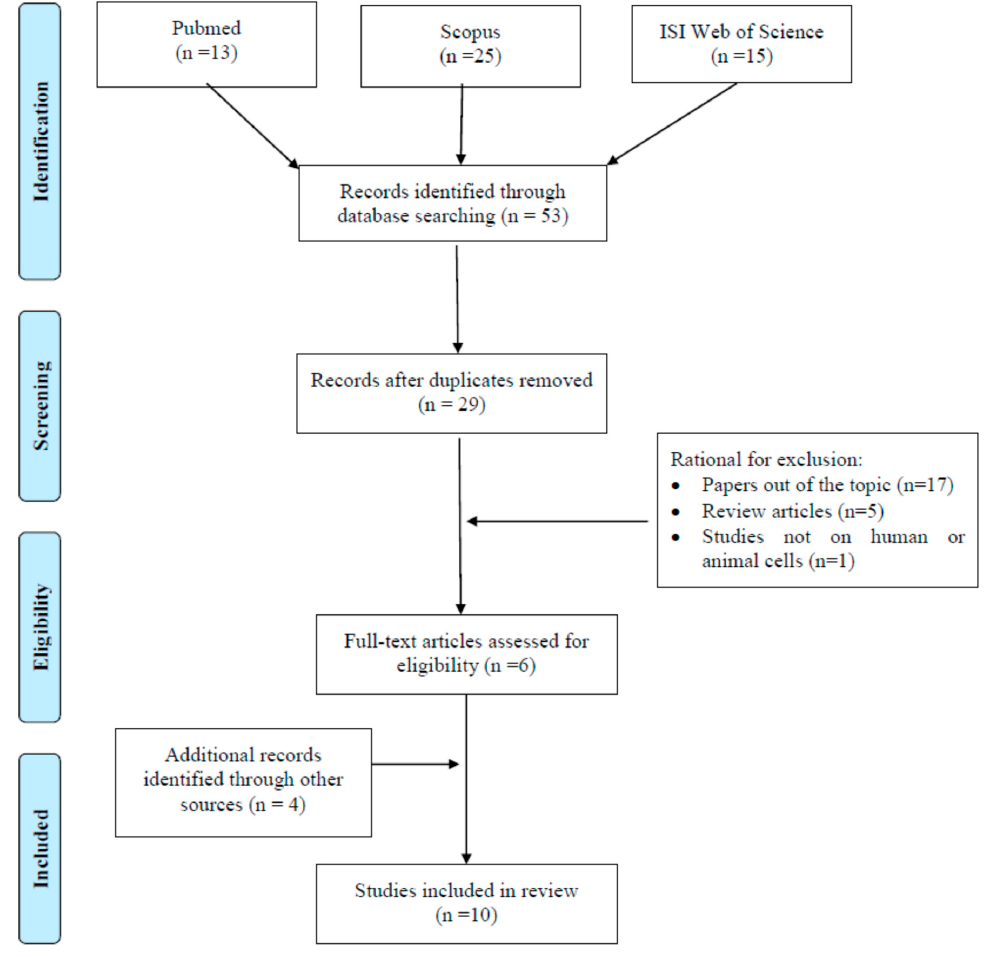
Figure 1. Flow diagram of literature search.